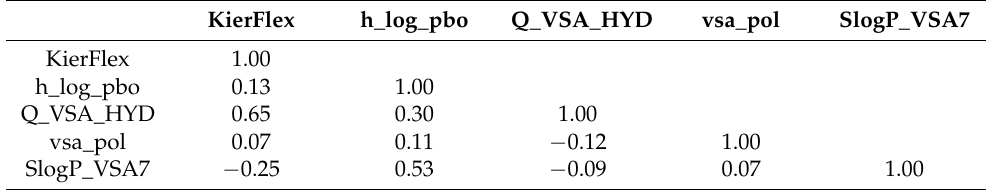
Table 2. Mutual correlation values for the 5 descriptors chosen for the QSAR equation.